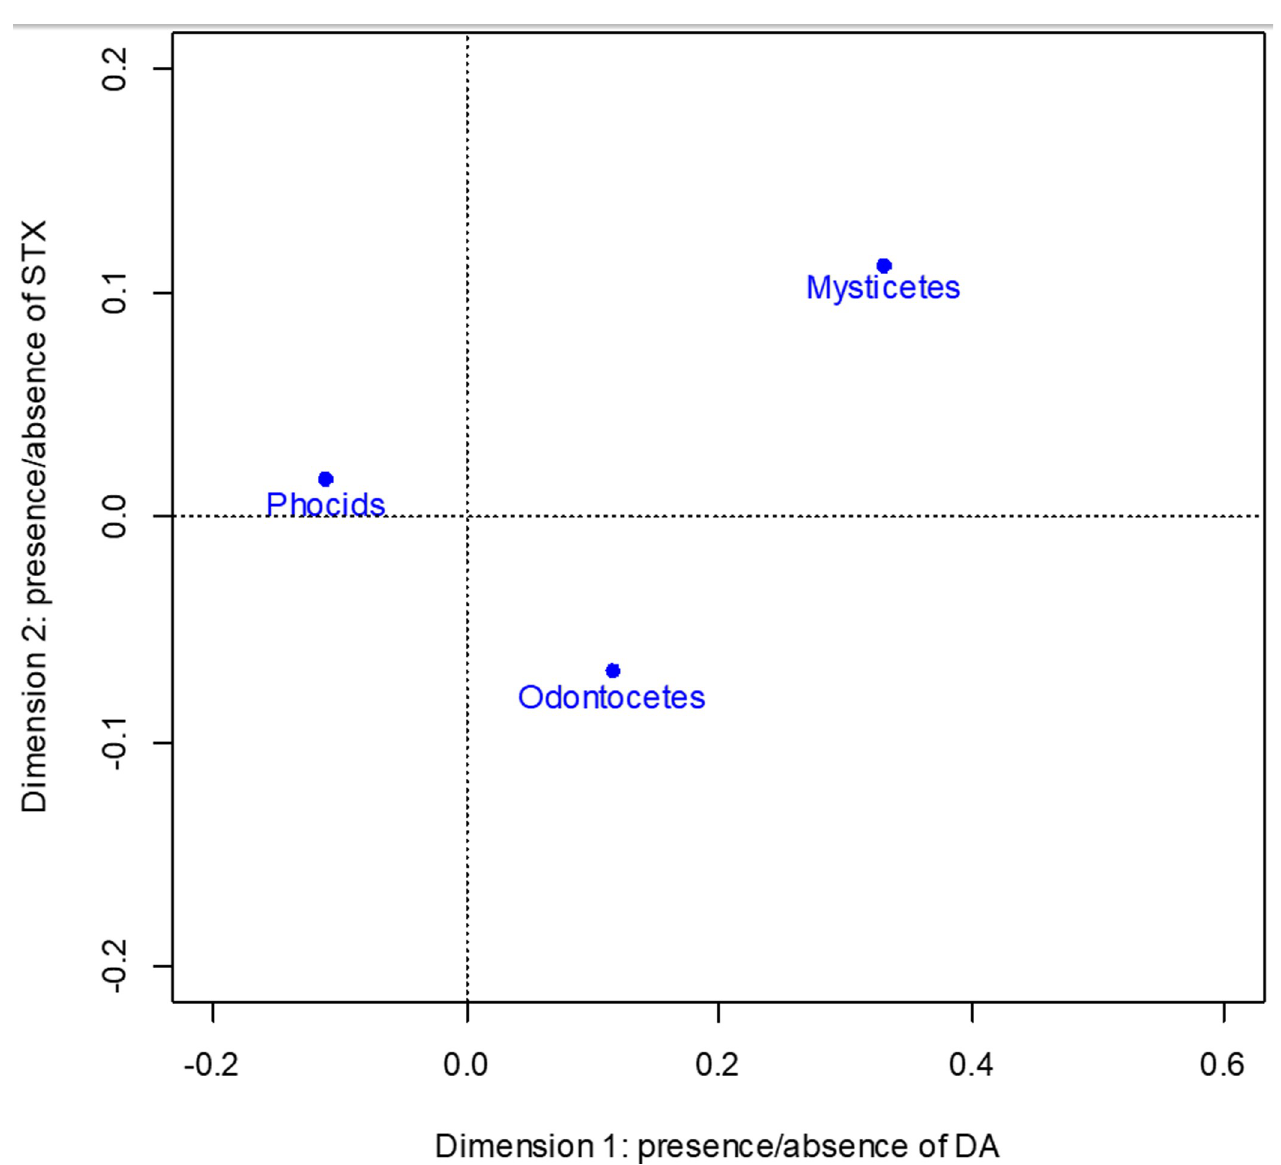
Fig 4. Correspondence analysis ordination for taxonomic group comparisons. Positive values for dimension 1 correlate with larger proportion of positive domoic acid samples and negative values correlate with larger proportion of negative domoic acidsamples. Positive values for dimension 2 correlate with larger proportion of positive saxitoxin samples and negative values correlate with larger proportion of negative saxitoxin